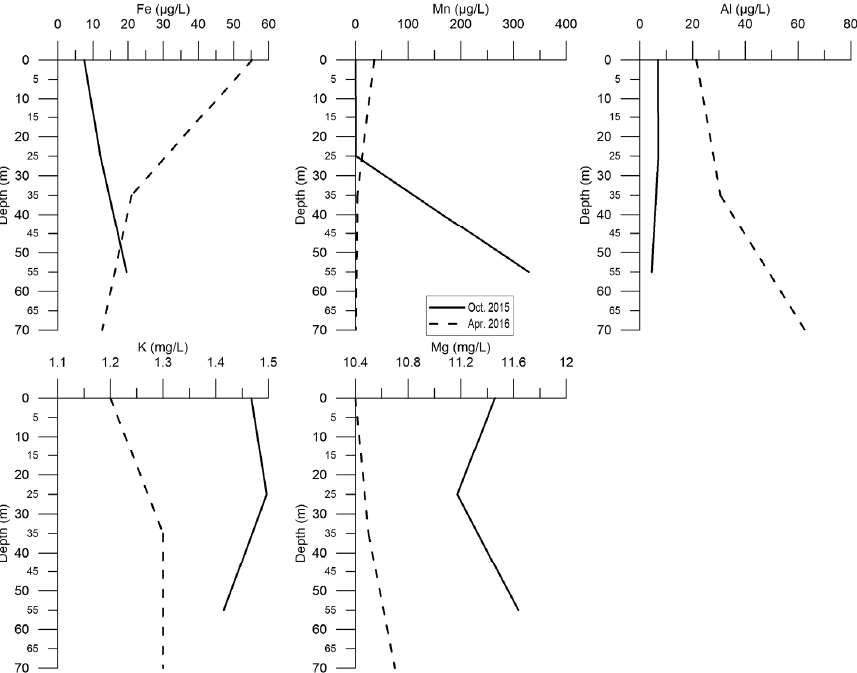
Figure 8. Fe, Mn, Al, K, and Mg concentrations along the water column in October 2015 and April 2016 via Niskin bottle sampling.